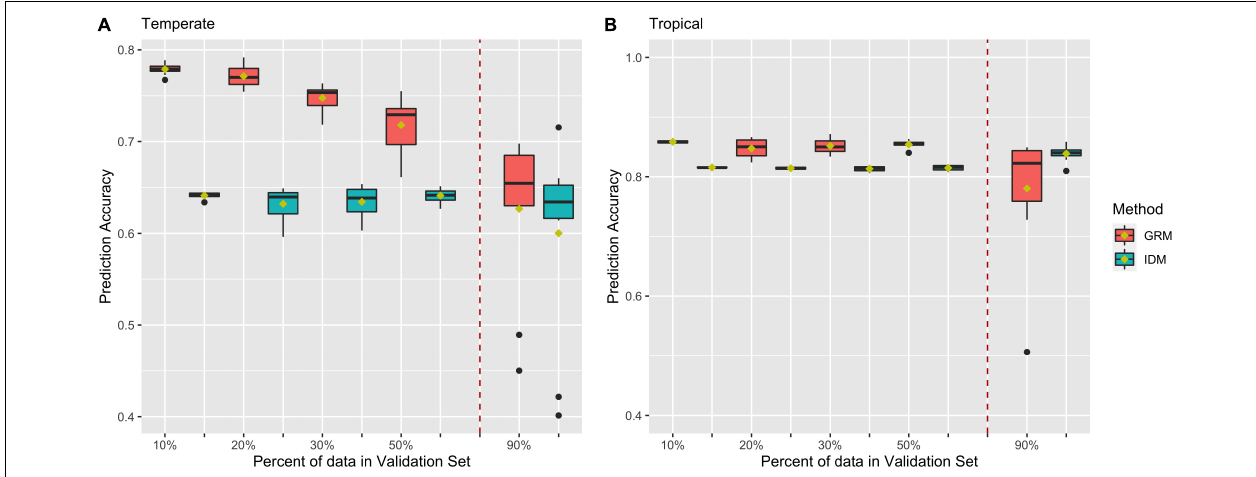
FIGURE 5 | Prediction accuracy for black layer water content (BWC) in temperate (A) and tropical (B) ecological zones from the CV2) scenario (left of the dashed line) and an CV_90 scenario where 90% of the inbred lines were selected and had BWC phenotypes set to missing (right of the dashed line). Methods “GRM” and “IDM” refer to multi-trait models using a genomic relation matrix or identity matrix for the genetic effect, respectively.